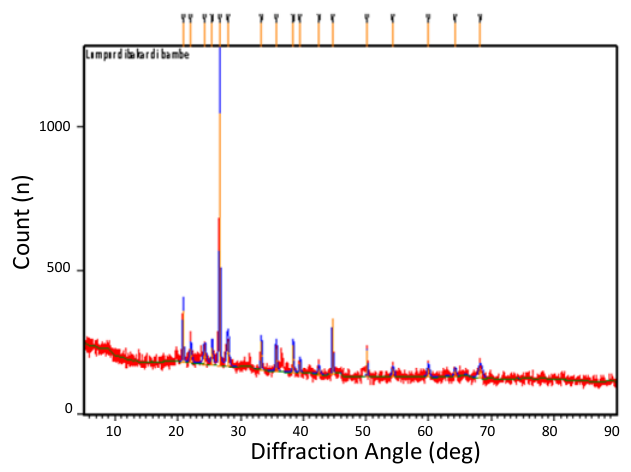
Figure 1. XRD result of sintered LUSI